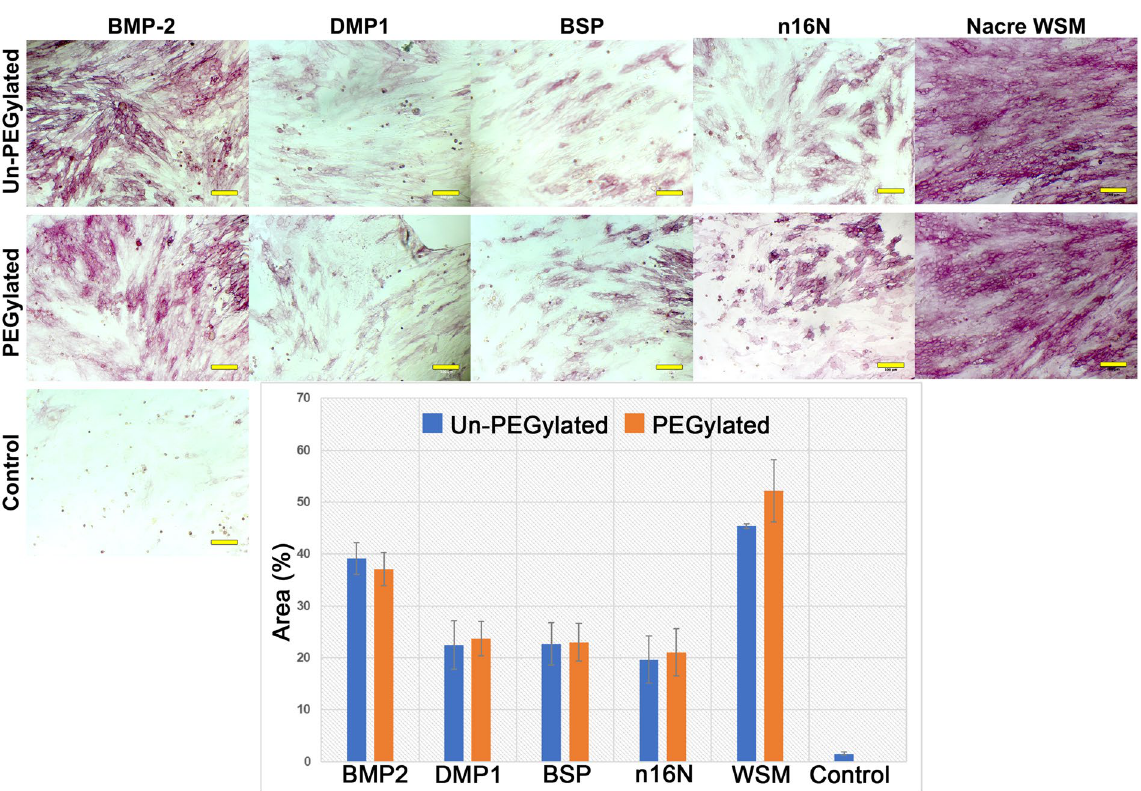
Figure 5. ALP-stained W-20-17 cells seeded onto PEGDA hydrogels incorporating PEGylated or non- PEGylated osteogenic proteins and peptides. Control cells were seeded on PEGDA hydrogels containing no proteins. ALP expression in W-20-17 cells was thresholded, then quantified as percent area covered. Error bars indicate standard deviation. Scale bars are 100 µm. Images were uniformly adjusted for brightness and